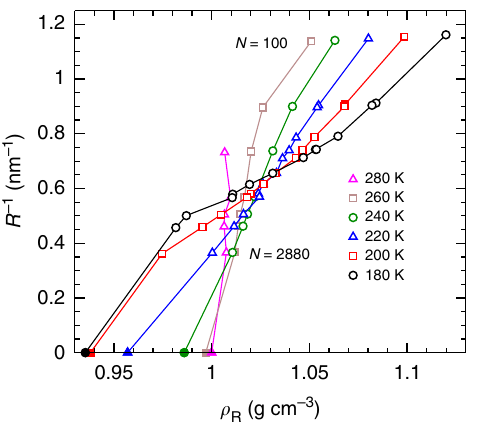
Fig. 2 Variation of nanodroplet radius R with temperature T and number of molecules N . Isotherms of R − 1 versus the effective droplet density ρ R = 3 mN /4 π R 3 . The statistical error for both R − 1 and ρ R is smaller than the symbol size. N decreases with increasing R − 1 along each isotherm. The fi lled symbols locate the bulk behaviour expected for droplets as R → ∞ and N → ∞ . Each of the anomalous features enumerated above for the bulk EOS is also observed in the nanodroplet isotherms derived from R ( N , T ) and plotted in Fig. 2. That is, the nanodroplet isotherms for R − 1 versus ρ R also cross; in fl ect at low T ; and − 1 in which the slope decreases as T decreases. exhibit a range of R